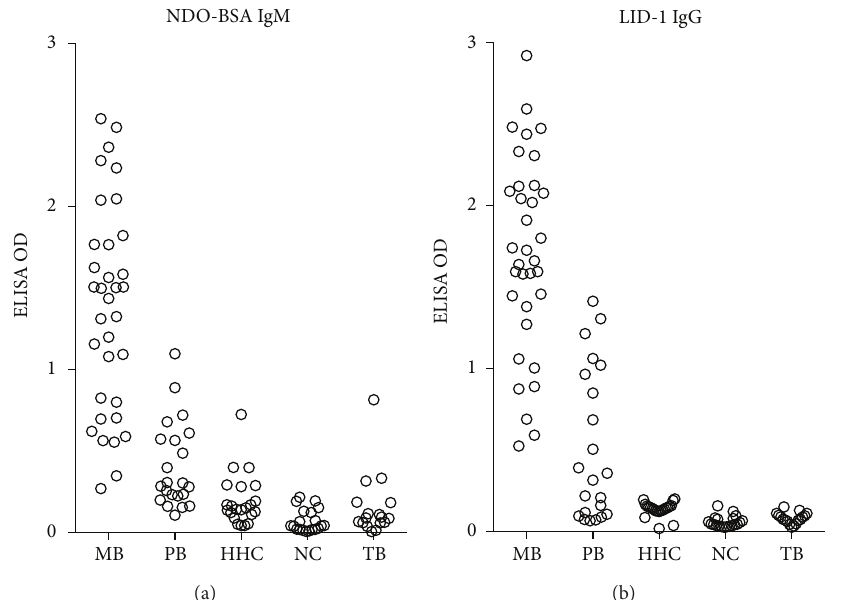
F 1: Antibody responses of leprosy patients in Yunnan Province. Sera from leprosy patients (MB = 34 and PB = 23), healthy household contacts of MB patients (HHC = 22), pulmonary tuberculosis patients (TB = 17), and uninfected controls (NC; 10 from Yunnan and 10 from Beijing) were assessed by ELISA against ND-O-BSA and LID-1. Glycolipid reactivity was assessed by IgM binding, and protein reactivity was assessed by IgG binding, with each sample distinguished by an individual marker.